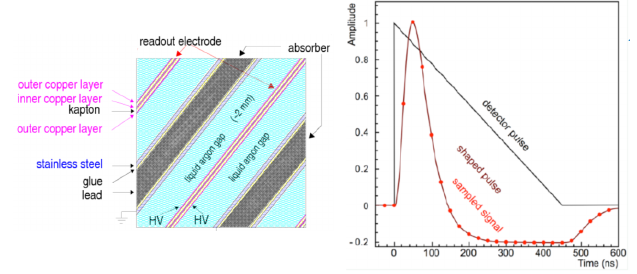
Figure 2: Diagrams of the structure of a sampling layer of the ATLAS EM calorimeter (left) and a pulse shape read out from the detector before and after shaping and sampling (right) [4].